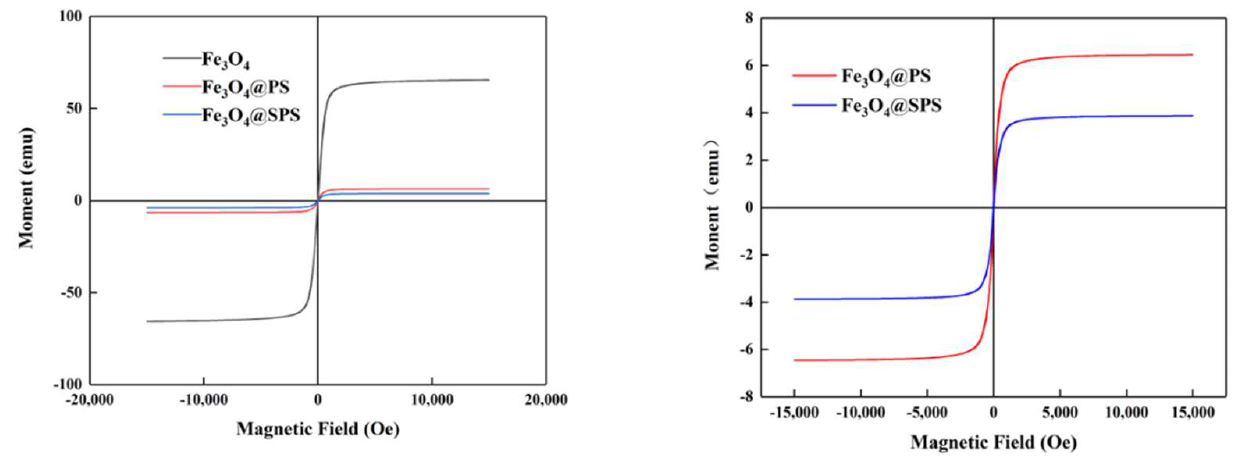
Figure 4. Hysteresis lines of Fe 3 O 4 , Fe 3 O 4 @PS and Fe 3 O 4 @SPS.